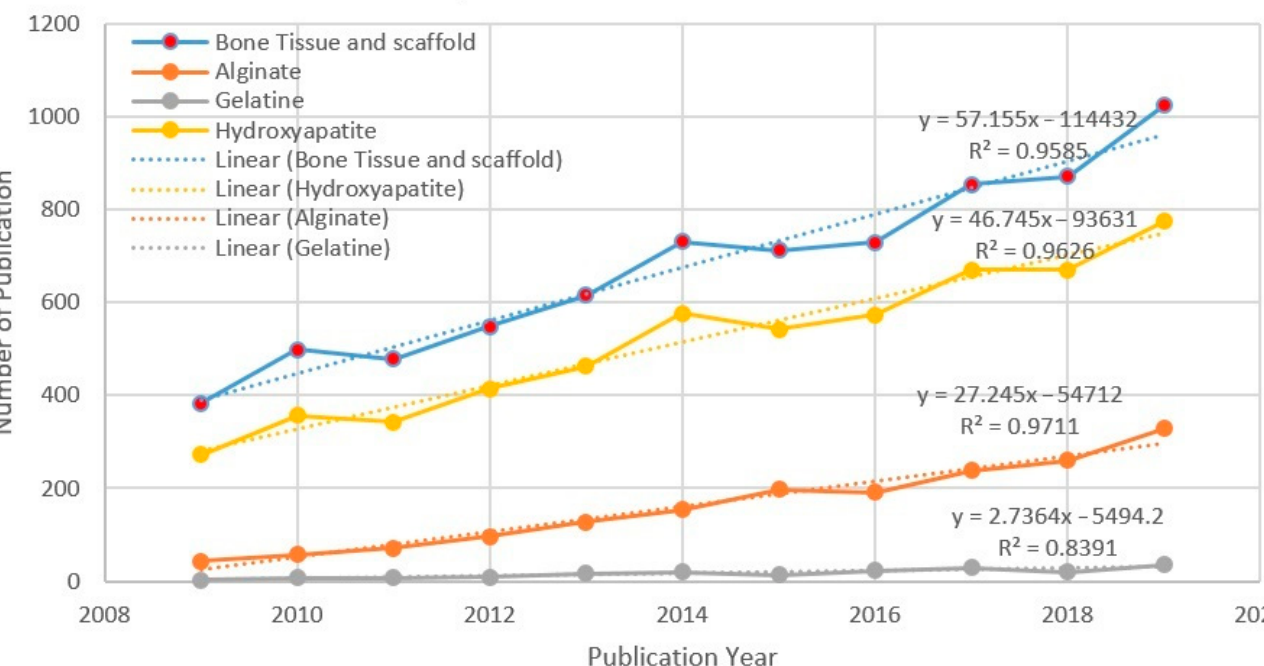
Figure 3. Number of publications per year (2009–2019).